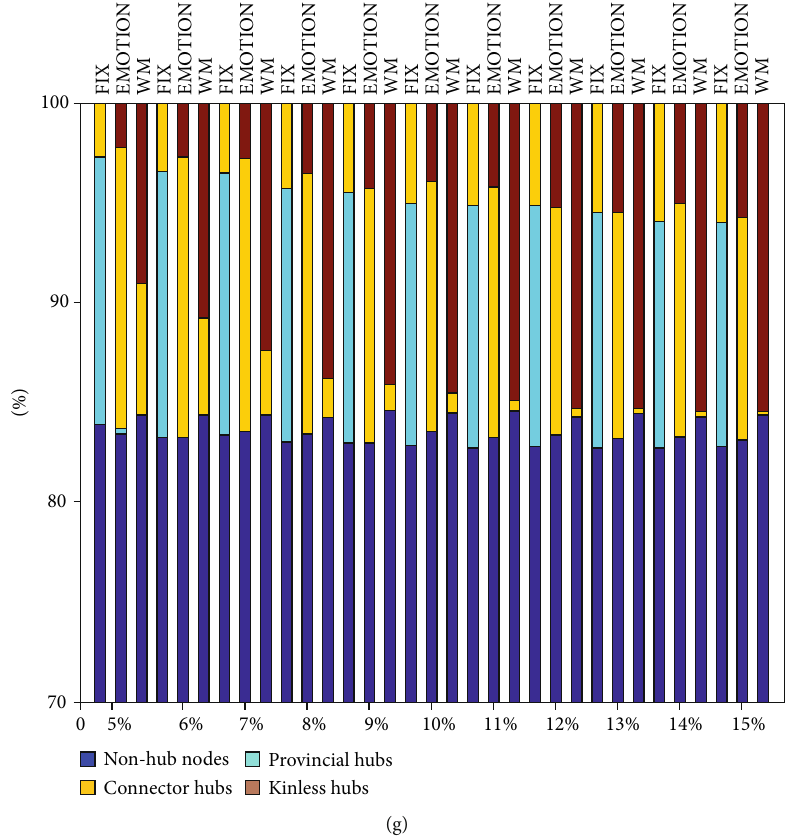
Figure 4: The hub distribution within 305 nodes for 81 subjects. (a, c, and e) Separately describe the hub distribution of FIX, EMOTION, and WM networks at the threshold of 10%. (b, d, and f) Separately describe the subject ratio of each hub in FIX, EMOTION, and WM networks at the threshold of 10%. (g) Describes the mean ratio of the hubs across all 305 nodes and all subjects at the 5-10%